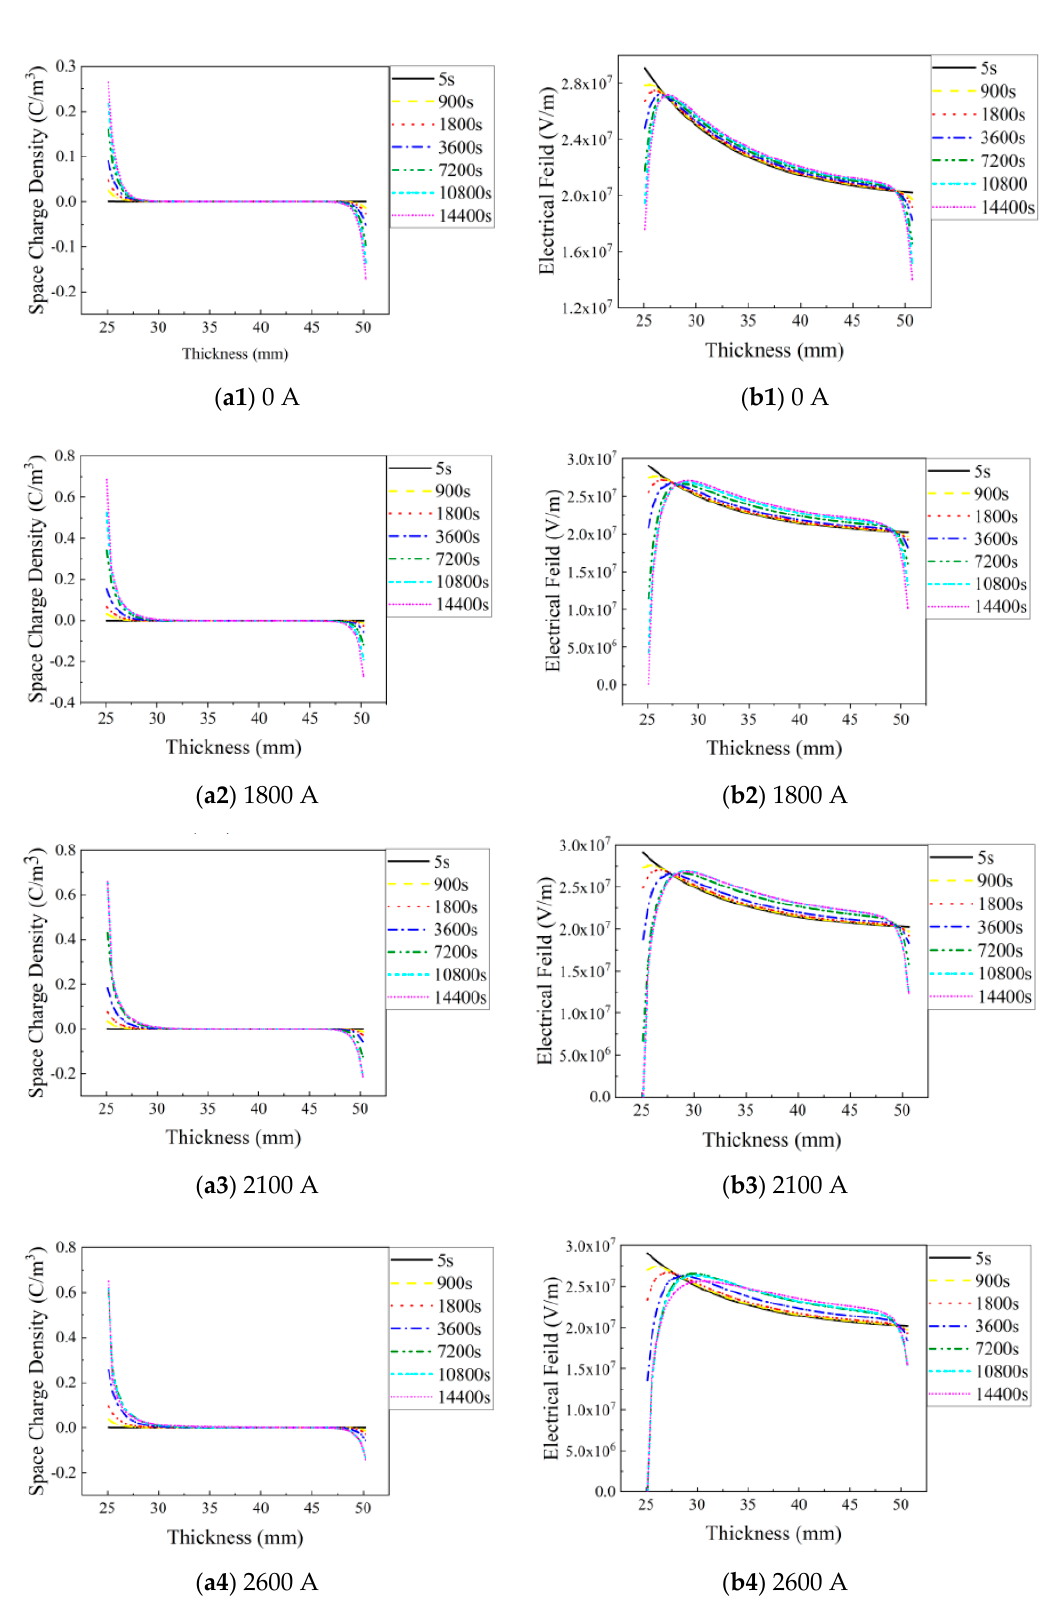
Figure 13. Simulation results of space charge distribution ( a1 - a4 ) and electric field distribution ( b1 - b4 ) in HVDC insulation when the trap density is 1000 × 10 19 m − 3 , the trap depth is 1.20 eV with a load current varying from 0 to 2600 A under 592 kV.